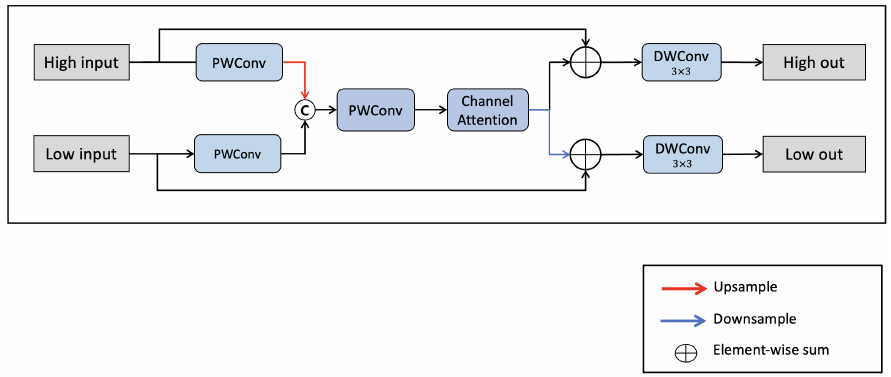
Figure 6. Structure of the feature fusion